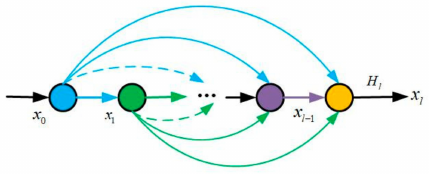
Figure 2. The dense